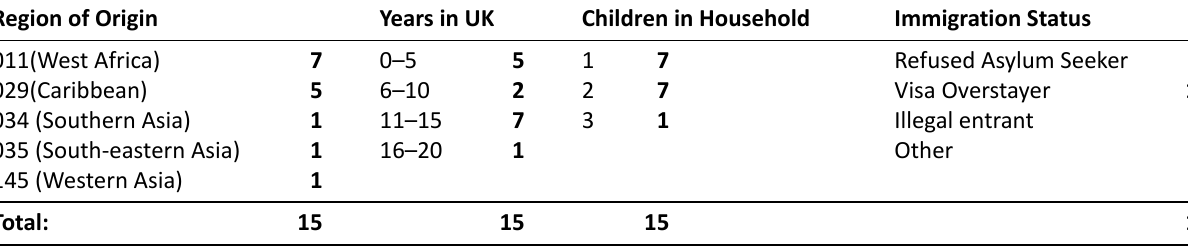
Table 1. Demographics of